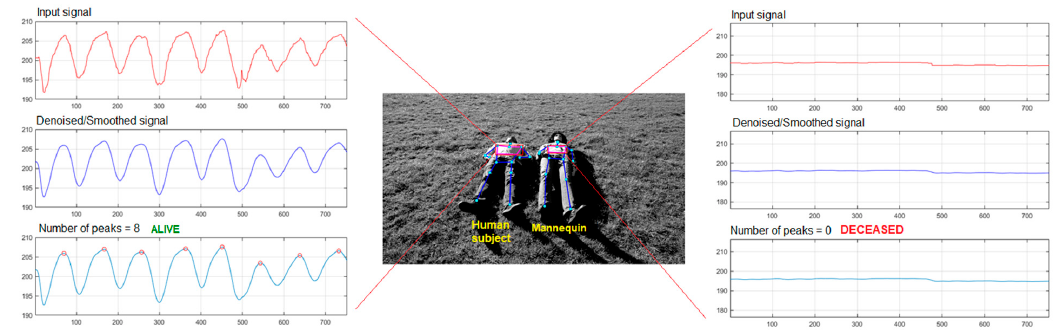
Figure 9. Multiple subject detection.